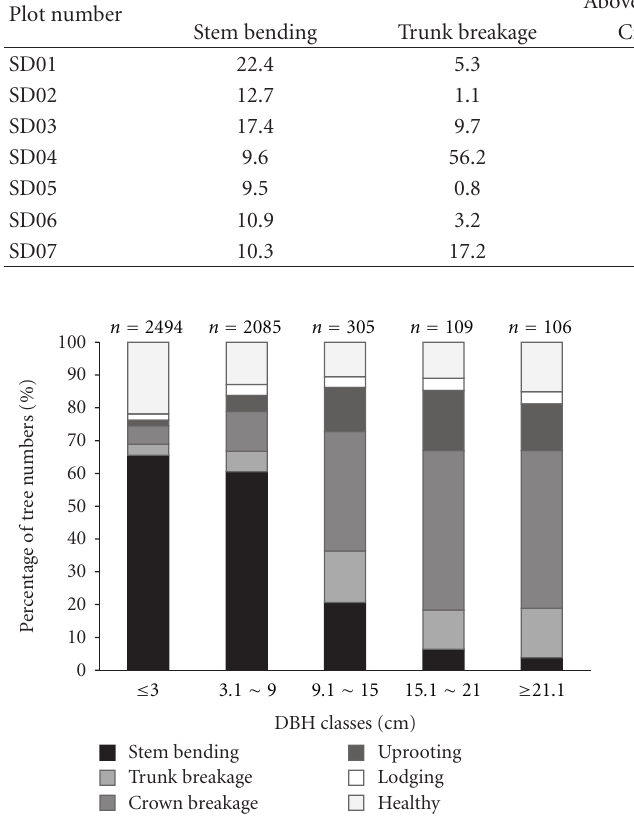
Table 3: Biomass distribution according to six categories of damage in the seven plots in 2008. Plot number